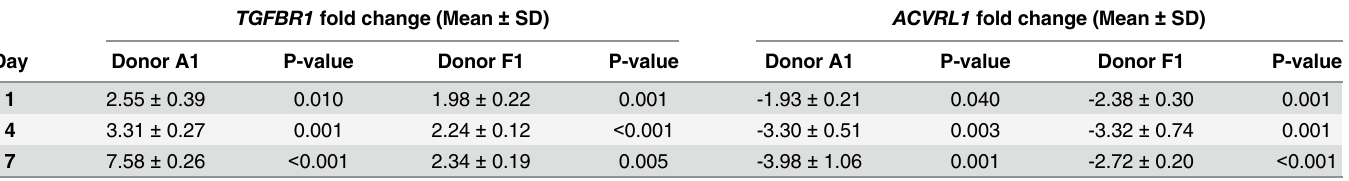
Table 2. TGF β increases TGFBR1 (ALK5) and decreases ACVRL1 (ALK1) in human BMSC